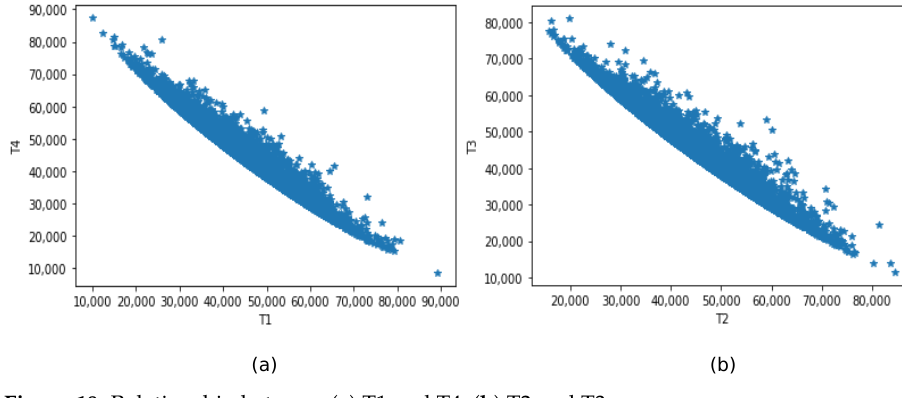
Figure 18. Relationship between ( a ) T1 and T4, ( b ) T2 and